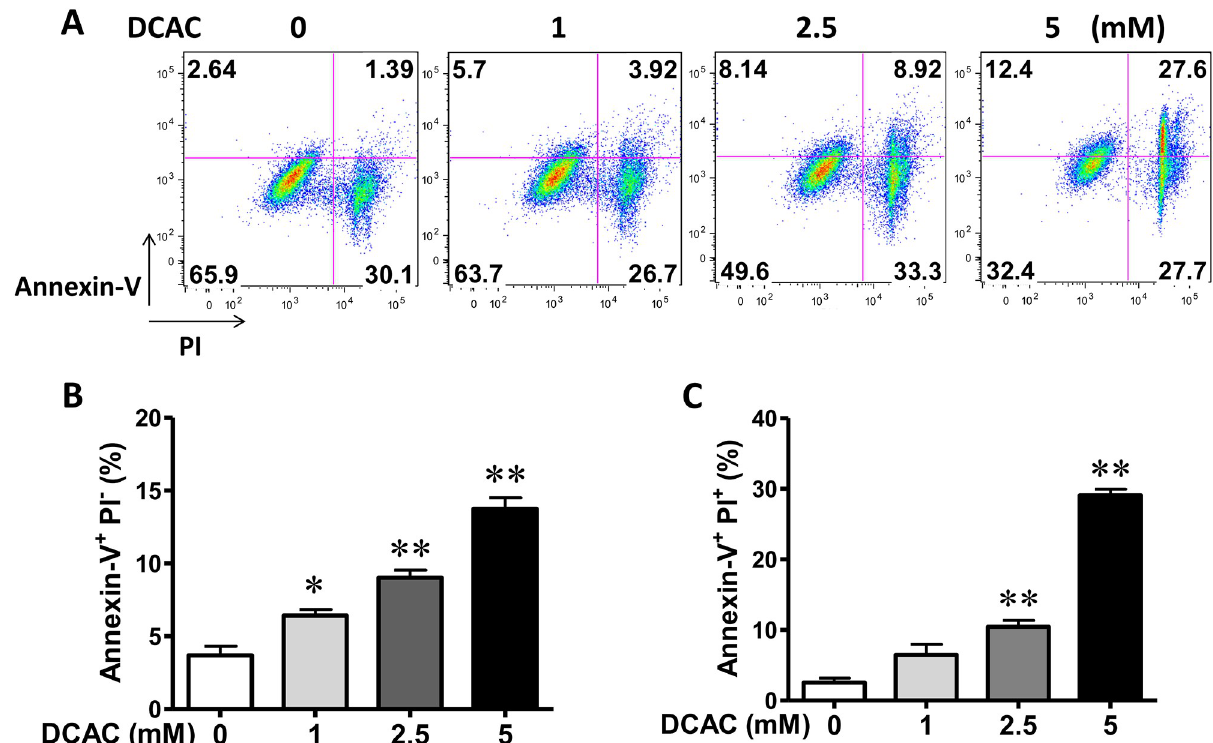
Fig 1. Effect of DCAC on apoptosis of KCs. Cells were exposed to DCAC at concentrations of 0, 1, 2.5 or 5 mM for 24 h. Cell apoptosis was determined by Annex V staining and detected by FACS. (A) Flow cytometry analysis of cell apoptosis. (B) The percentage of early and late-stage apoptotic cells are represented in histogram. n = 3 in each group. � p < 0.05; �� p < 0.01, as compared to the control.